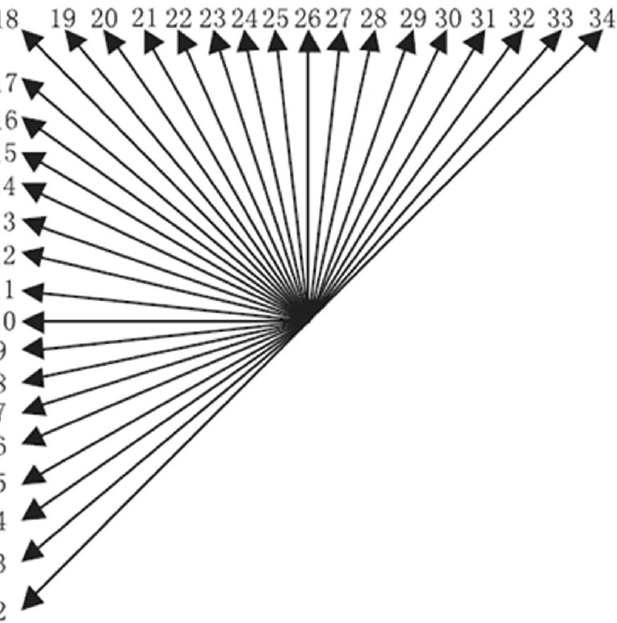
Figure 1. Modes in